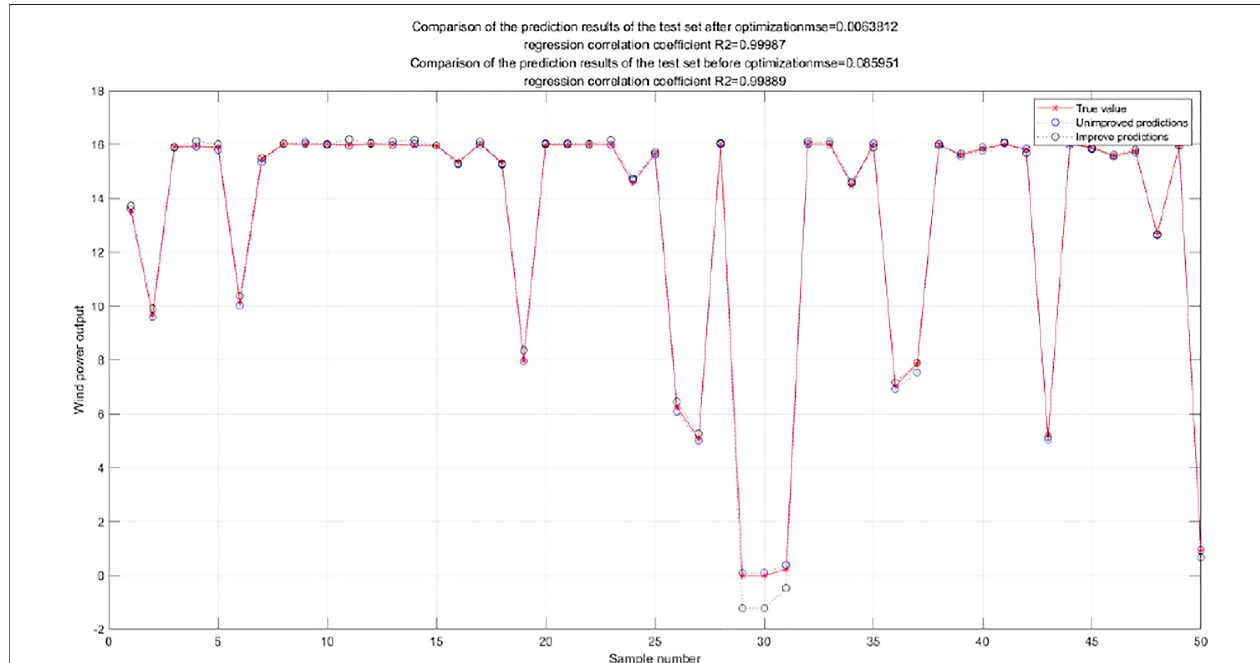
FIGURE 9 | Comparison diagram of CSO optimized BP neural network prediction.